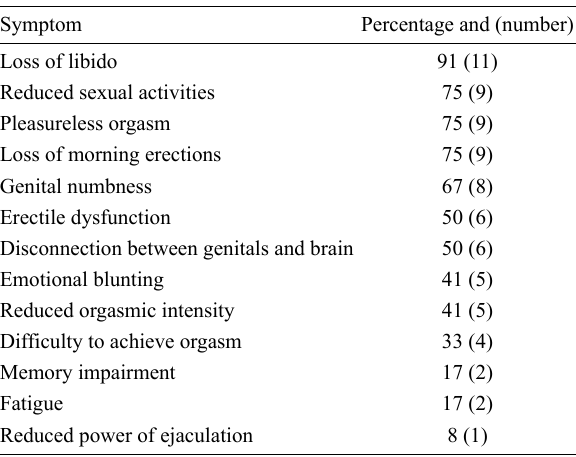
Table 3. Frequency of symptoms appearance according to patient’s